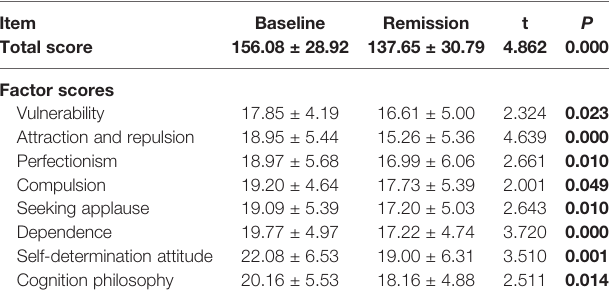
TABLE 4 | Comparison of the C-DAS-A total and factor scores in the rMDD subgroup before and after treatment. Item